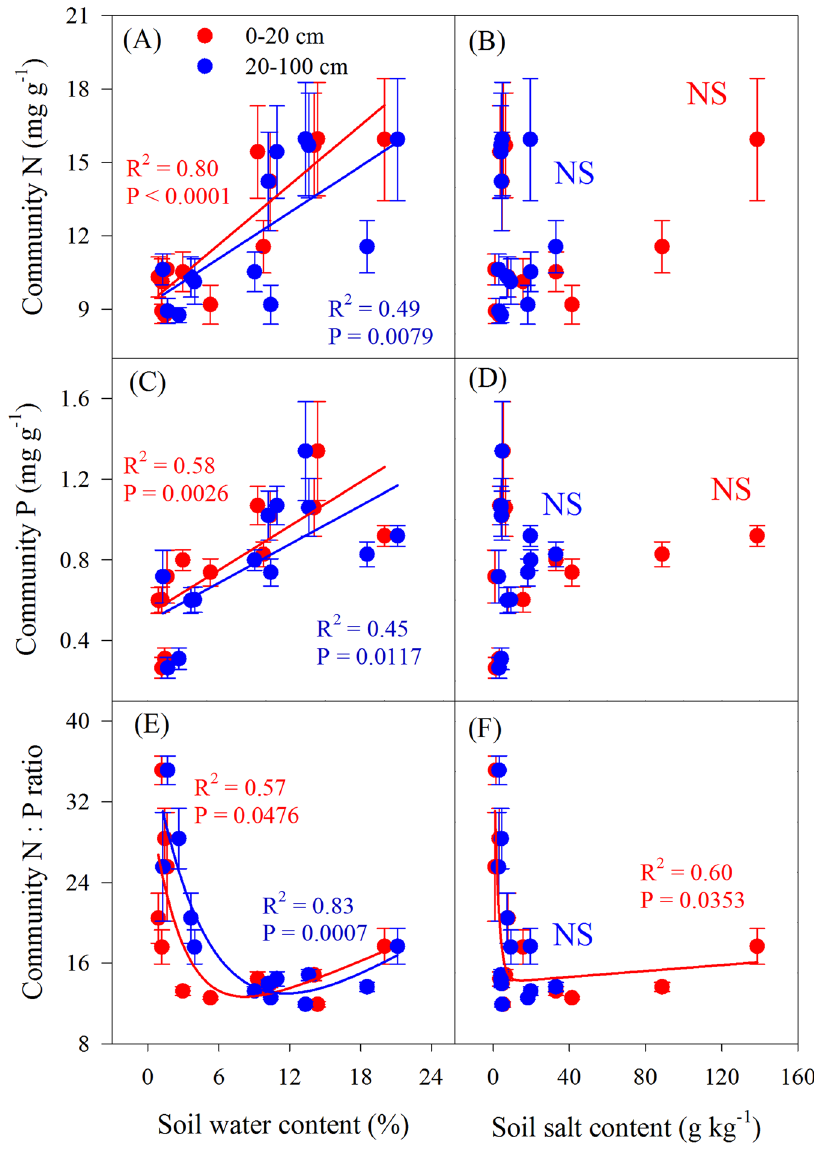
Figure 6. Relationships between plant community nutrients and either soil water or salt